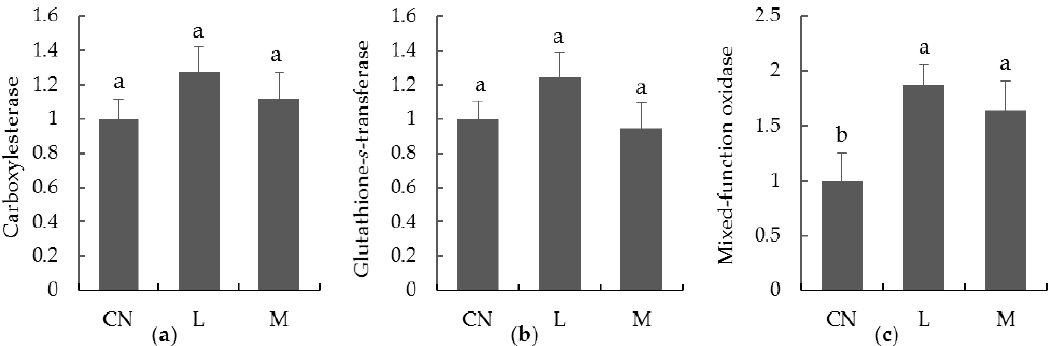
Figure 3. Effect of imidacloprid seed treatments on aphids’ detoxifying enzymes (average ± standard error), ( a ) carboxylesterase, ( b ) glutathione- s -transferase, and ( c ) mixed-function oxidase. CN: The controls; L: Seed coated by imidacloprid of low dose; M: Seed coated by imidacloprid of median dose. Different small letters show significant difference ( p < 0.05).